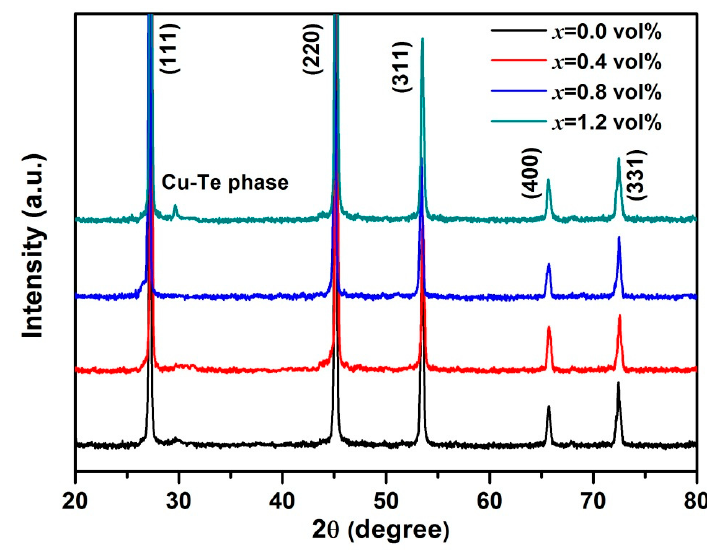
Figure 3. X-ray diffraction patterns of Cu–Te/Cu 2 SnSe 3 composites. Figure 3. X-ray di ff raction patterns of Cu–Te / Cu